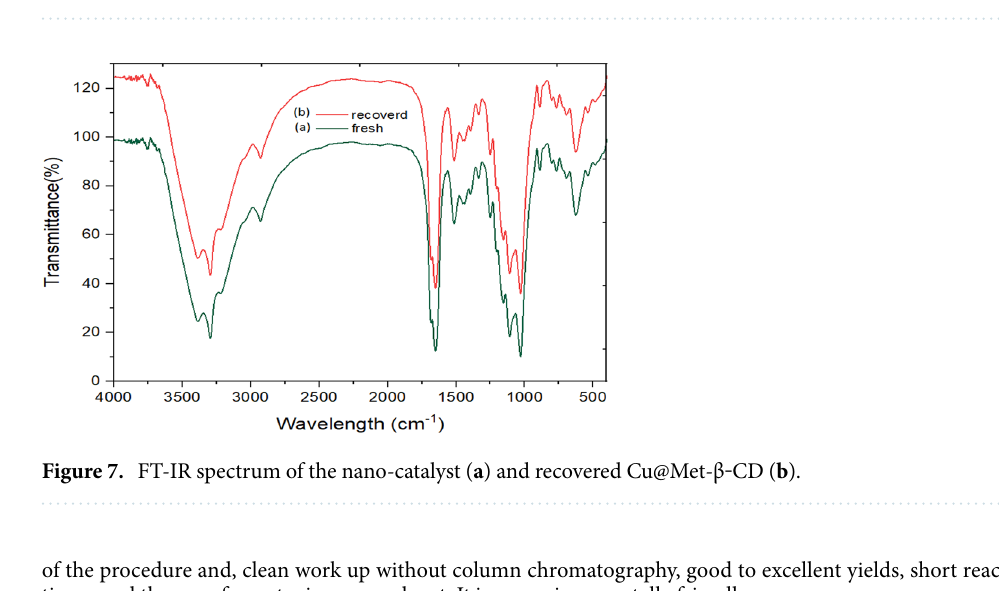
Figure 6. Recycling of the catalyst, in the synthesis of 4-(4-hydroxybenzylidene)-3-methylisoxazol-5(4H)-one.